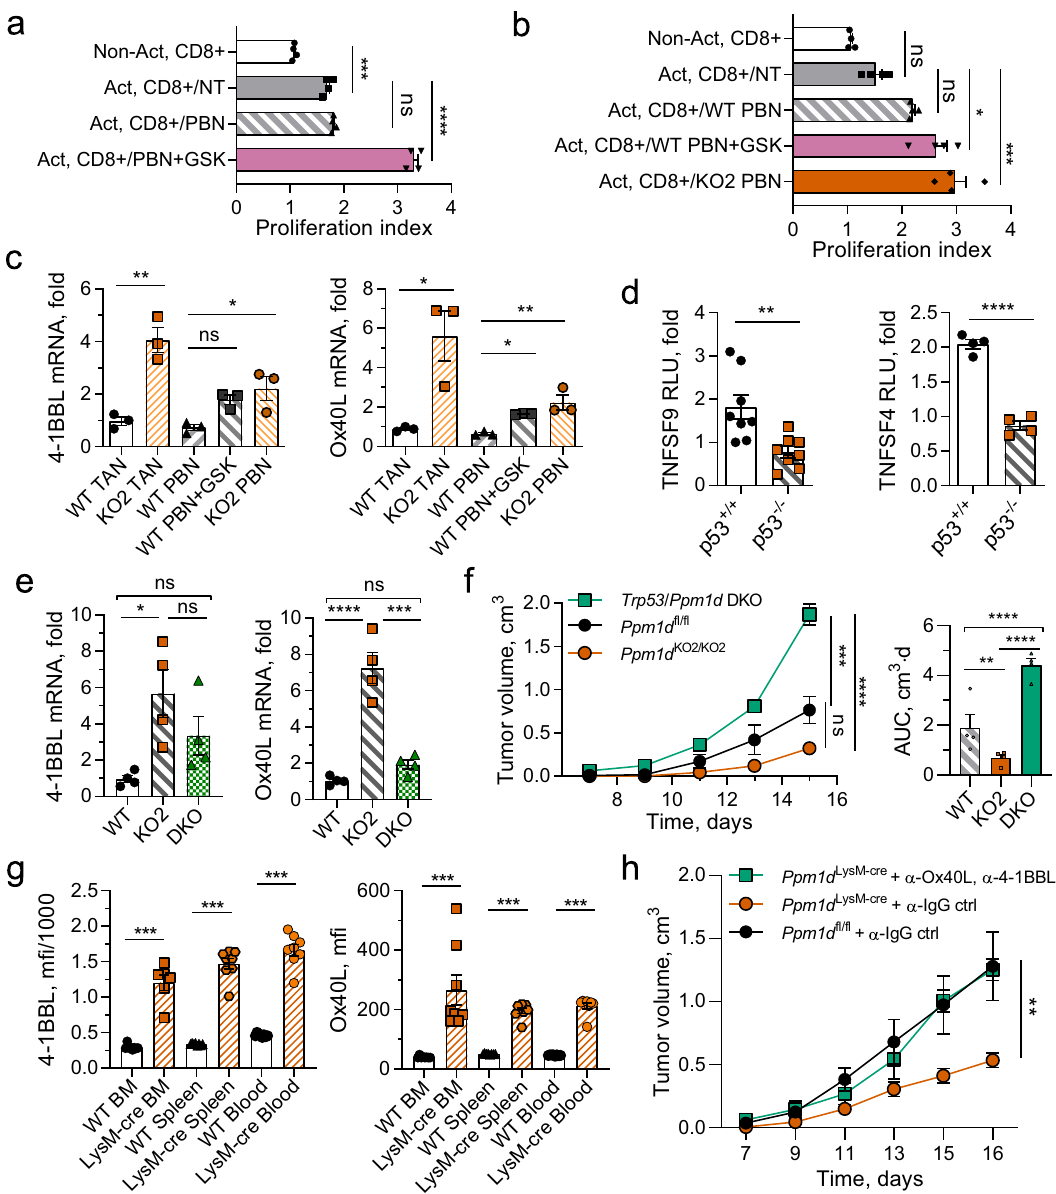
Fig. 5 Chemical inhibition of Wip1 or genetic knockout of Ppm1d in neutrophils increased cytotoxic T-cell survival through p53-dependent induction of costimulatory ligands. a Proliferation of human cytotoxic T lymphocytes. Human donor blood CD8 + lymphocytes were not activated (Non-Act) or activated by incubation with CD3/28 beads (Act.) and cultured alone (NT), or coincubated with isolated human donor blood neutrophils pretreated for 6 h with vehicle (PBN) or 5 μ M GSK2830371 (PBN + GSK) ( n = 4 each condition). b Proliferation of murine cytotoxic T lymphocytes. Ppm1d + / +